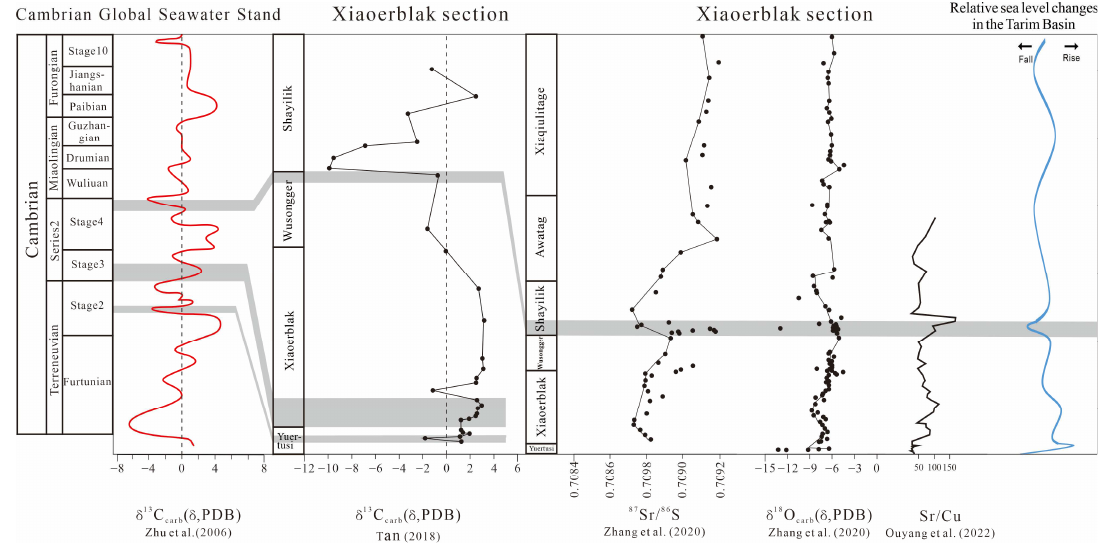
Figure 8. Cambrian global δ 13 C carb (δ, PDB, peedee belemnite) variation curve [78], the Xiaoerblak section δ 13 C carb (δ, PDB) [77], 87 Sr/ 86 Sr, δ 18 O carb (δ, PDB) [43], and Sr/Cu [32] change curve and corre- sponding relative sea level change in Tarim Basin.